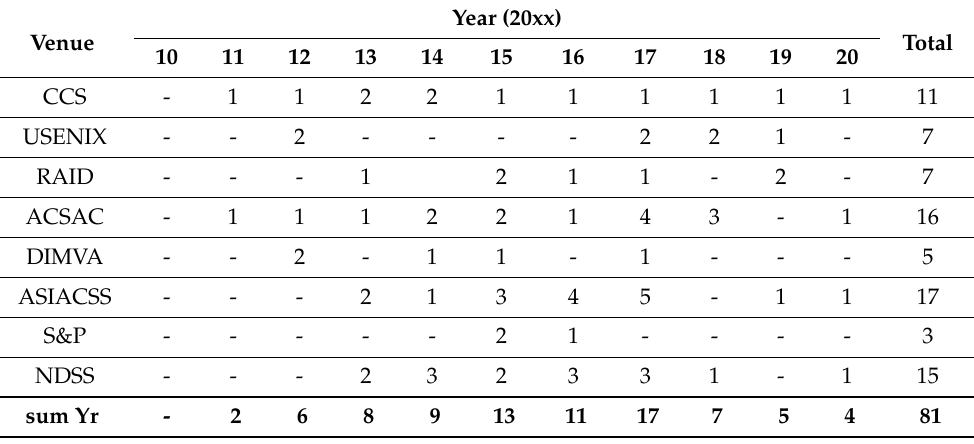
Table A1. Distribution of papers where a dataset with Android malware was used with respect to conferences and